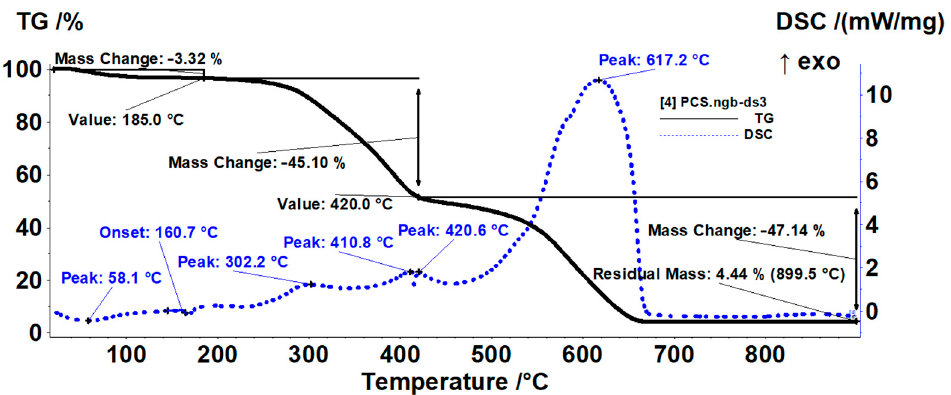
Figure 10. Detailed thermal diagrams of the composite membranes.